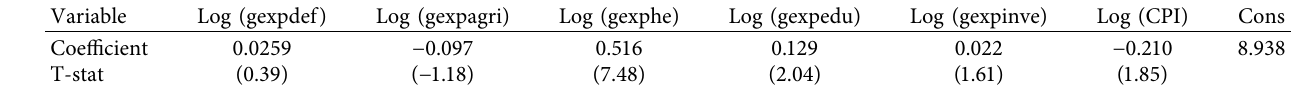
Table 6: Vector error correction